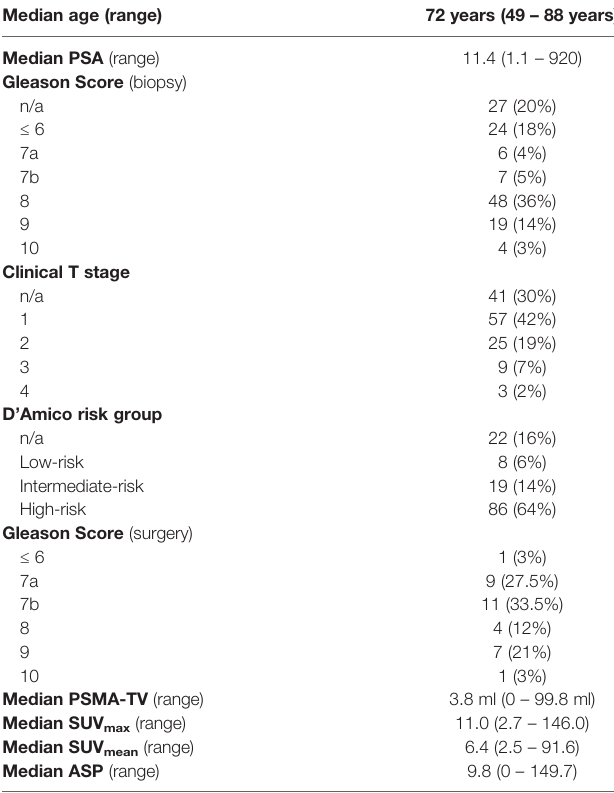
TABLE 1 | Patient and PSMA-PET tumor characteristics.